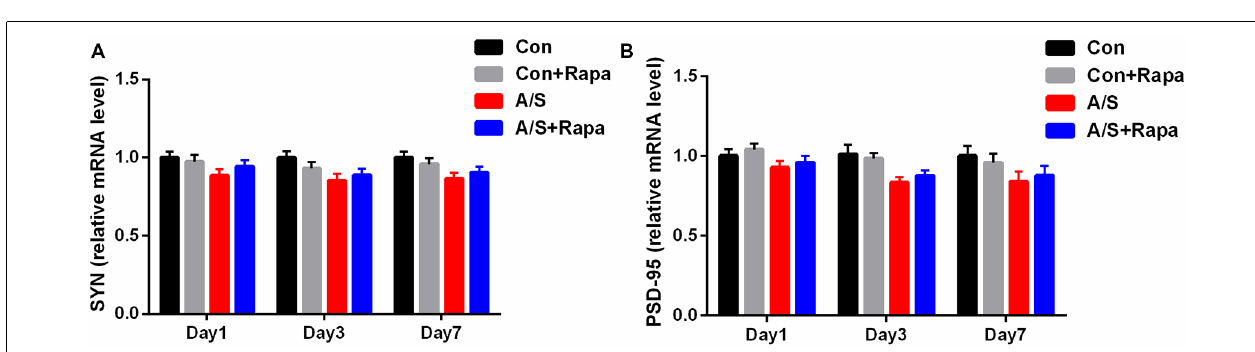
FIGURE 6 | Anesthesia/surgery and treatment with rapamycin were not significantly affected the mRNA levels of SYN and PSD-95. (A,B) SYN and PSD-95 mRNA levels in the hippocampus on days 1, 3, and 7 after anesthesia/surgery. Data are mean ± SEM ( n = 6 per group). Con, control group; Con+Rapa, control group with rapamycin pretreatment; A/S, anesthesia/surgery group; A/S+Rapa, anesthesia/surgery group combined with rapamycin